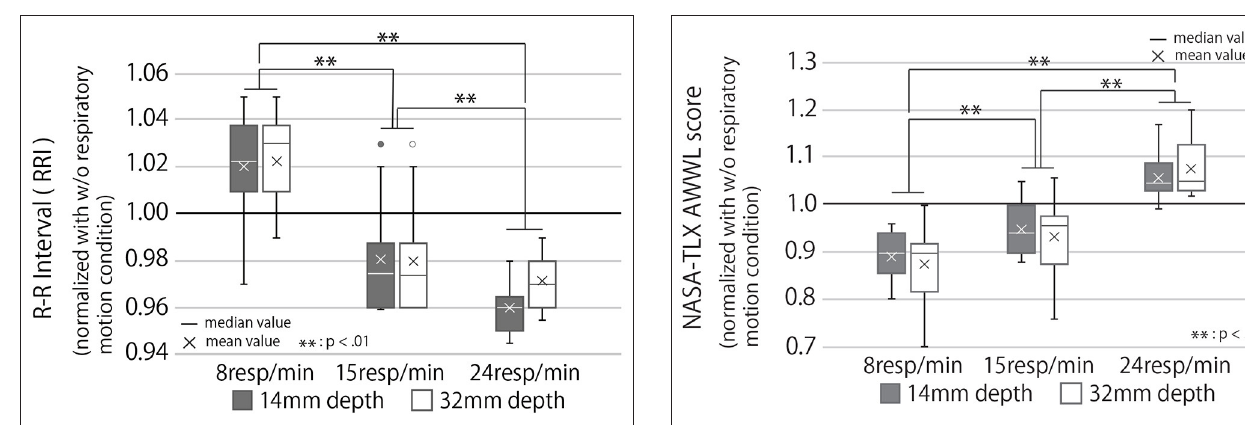
FIGURE 11 | RR interval during the breaking phase under each condition normalized with the condition of no respiratory motion. The RRI is the interval between the R waves that appear with each heartbeat. A high average value of RRI indicates parasympathetic dominance and a low stress level.